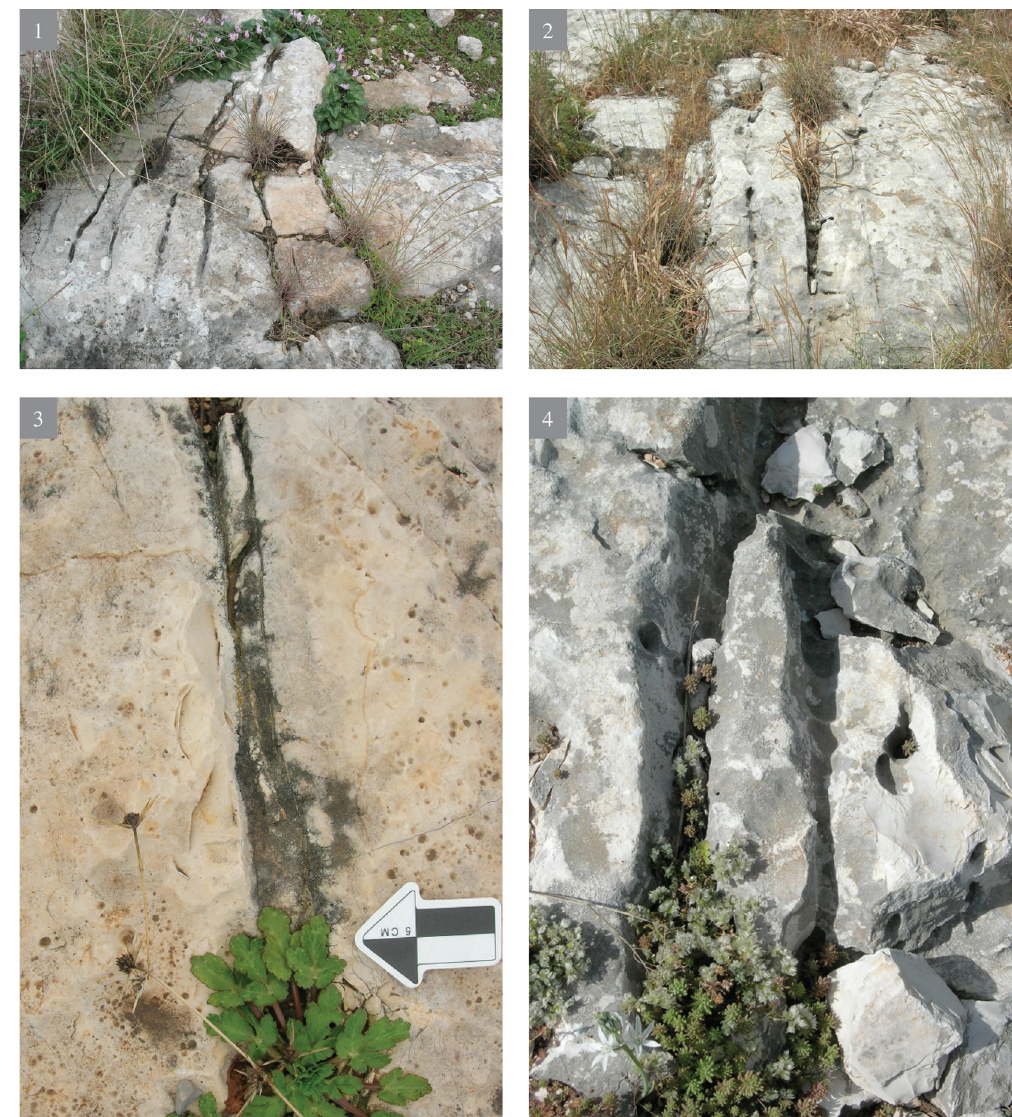
Fig 7. Rock markings indicating limestone quarrying. Drilling (no. 1–2); fissure widening (no. 2–4); flaking